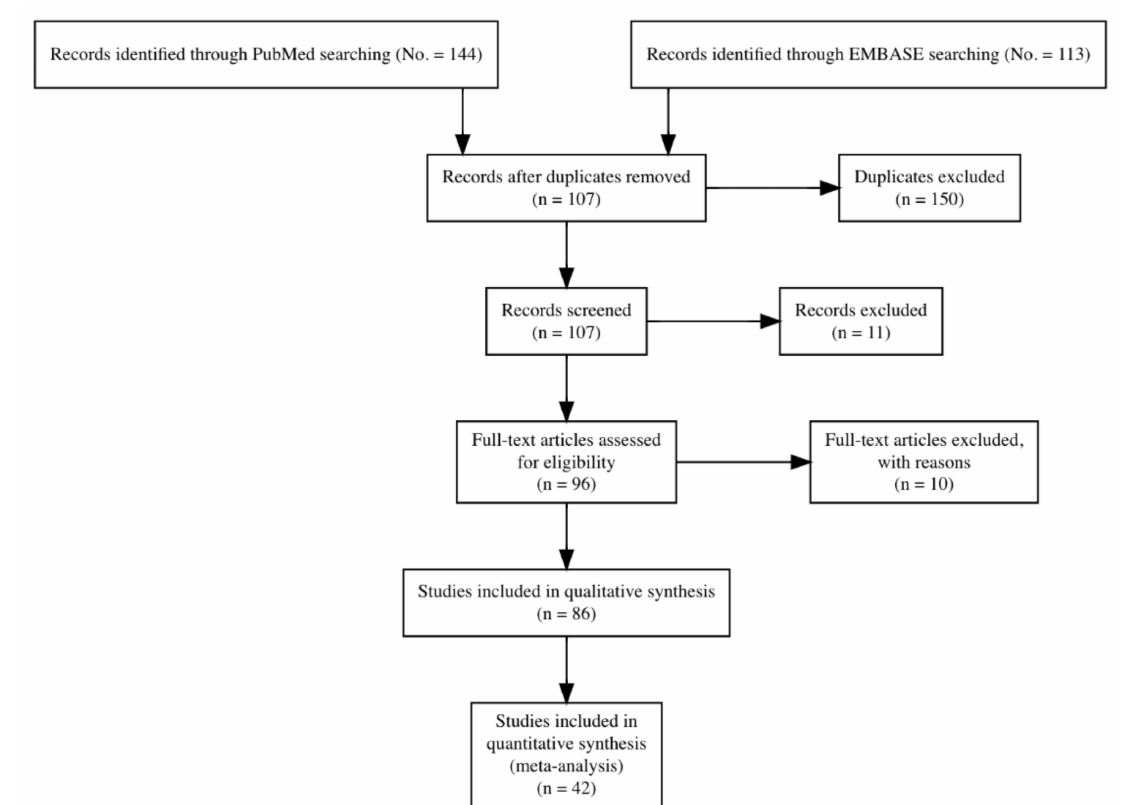
Figure 1. PRISMA flow chart for retrieved